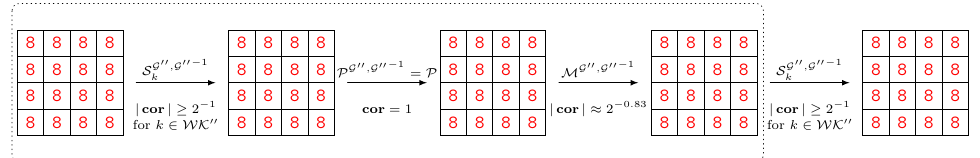
Figure 3: A G 00 -shifted linear trail for the Midori64 round that considers the intermediate 00 , G 00− 1 . masks after S G k